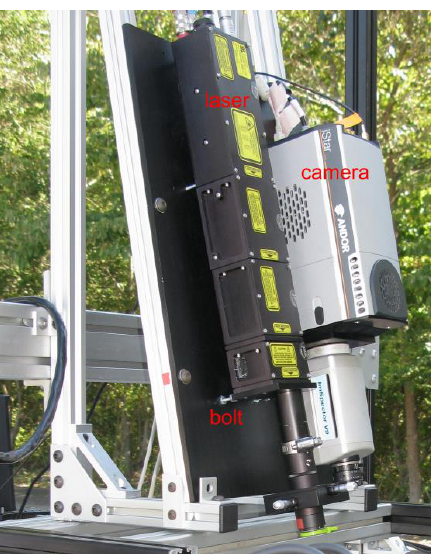
Figure 8. Platform for the camera and laser mounted on cart. The bolts that are attached to the laser and are used to adjust the plane of the laser are noted.